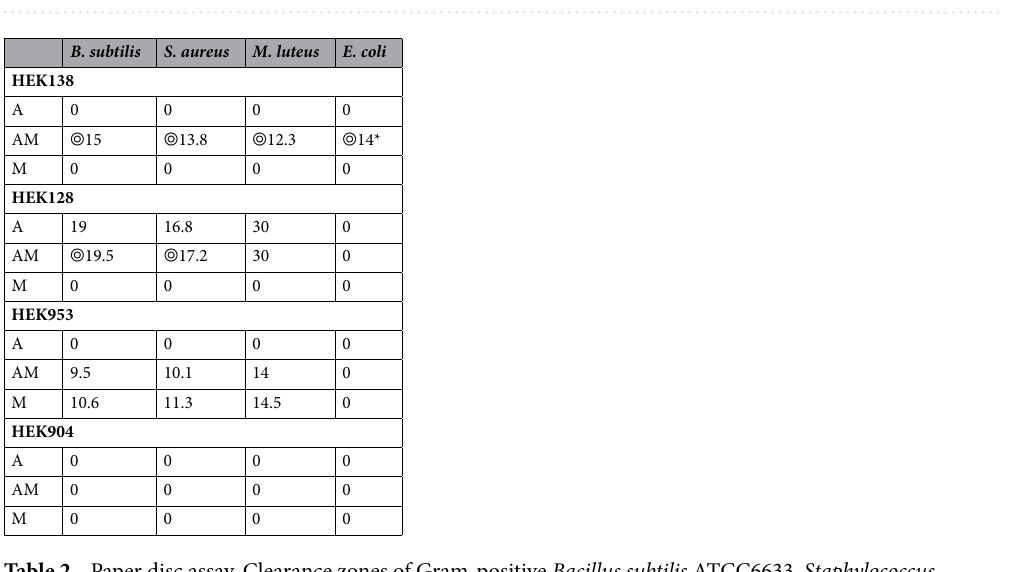
Figure 5. Paper disc assay. Clearance zones of Gram-positive Bacillus subtilis ATCC6633, Staphylococcus aureus 209PJC-1, Micrococcus luteus ATCC9341, and Gram-negative Escherichia coli NIHJ-2 were determined in response to extracts from culture of the natural pairs in combined-culture. (A: actinomycetes, M: MACB).